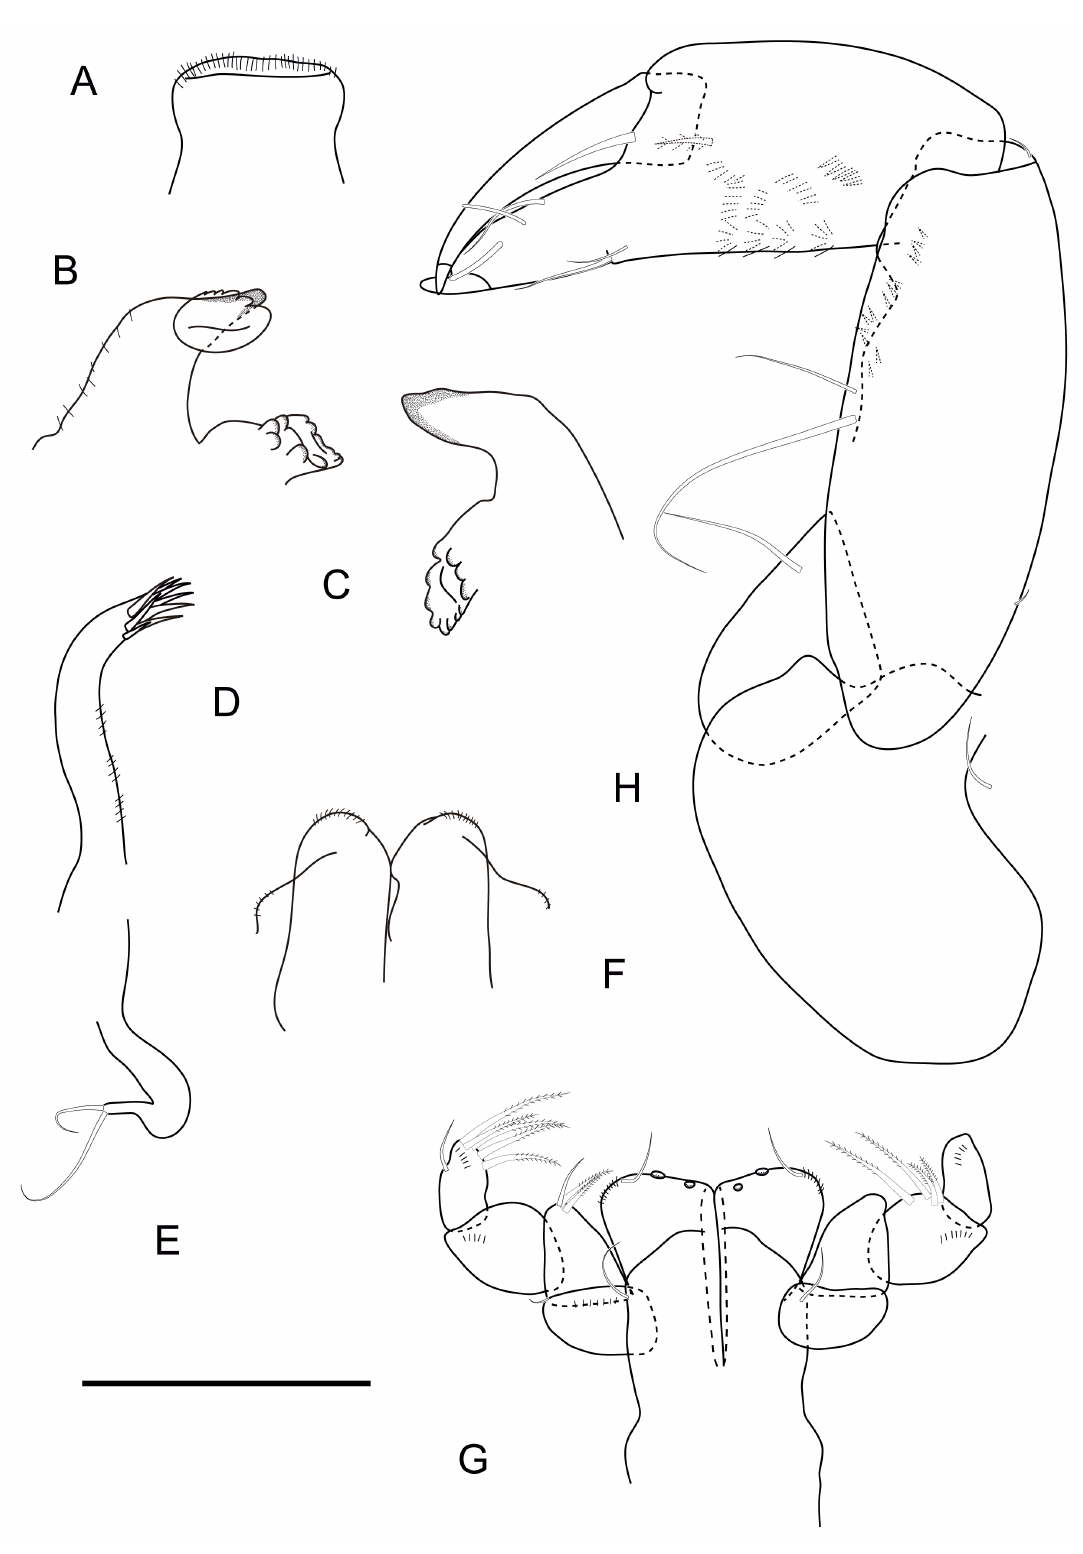
Fig. 9. Typhlotanais bolarticulus sp. nov., paratype (MZUSP 32878), ♀, dissected. A . Labrum. B . Left mandible. C . Right mandible. D . Maxillule. E . Maxillule palp. F . Labium. G . Maxilliped. H . Cheliped. Scale bar = 0.1